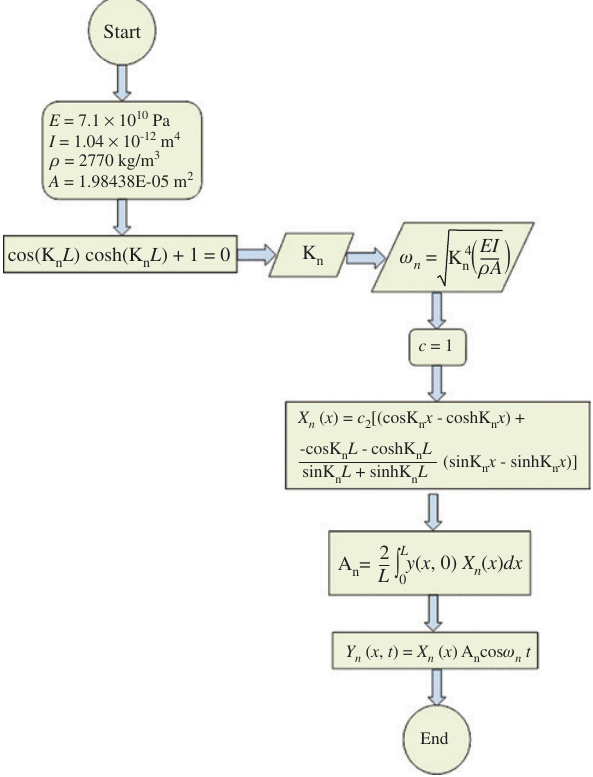
Figure 2: Flowchart of the MATLAB computer programming code used to solve the simply supported beam system.